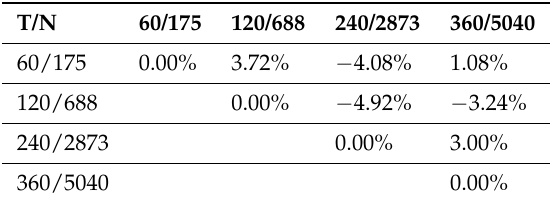
Table A1. Deviation due to revision for average returns of 12%/year. Sixty, 120, 240 and 360 months are simulated with 175, 688, 2873, and 5040 transaction pairs,